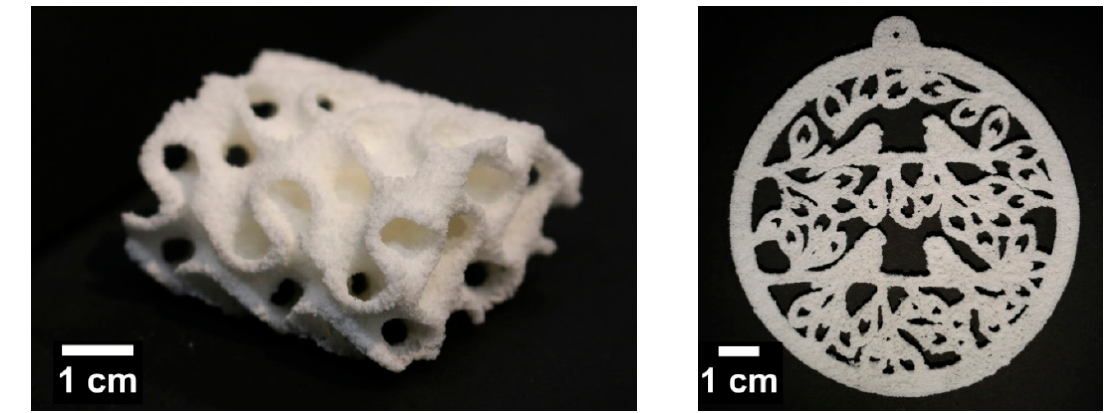
Figure 7. Test specimen printed from the developed POM feedstock powder. Left: gyroid. Right: ornament.